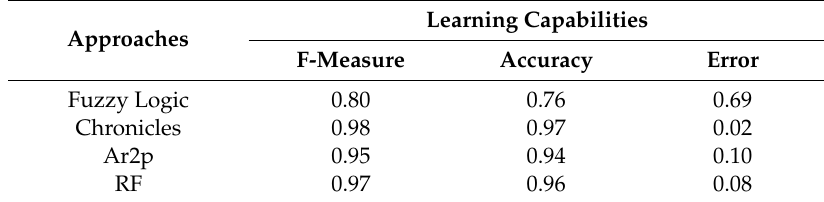
Table 12. General results for the Learning Capabilities.